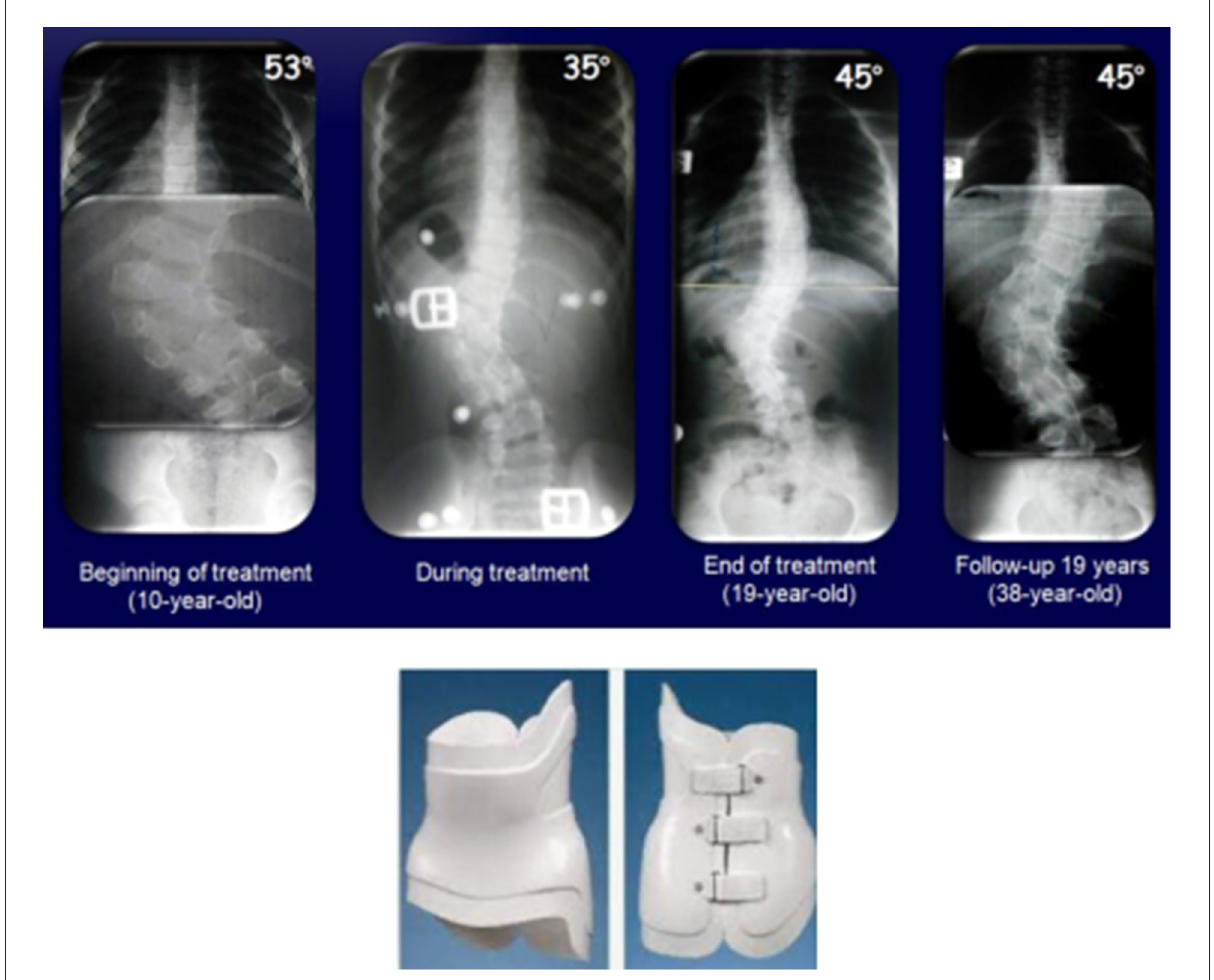
FIGURE2 A 10-years-old female with a hemivertebra in L2 and a T11-L4 (L5 sacralized) curve treated with the Boston brace for first year and then the PASB.